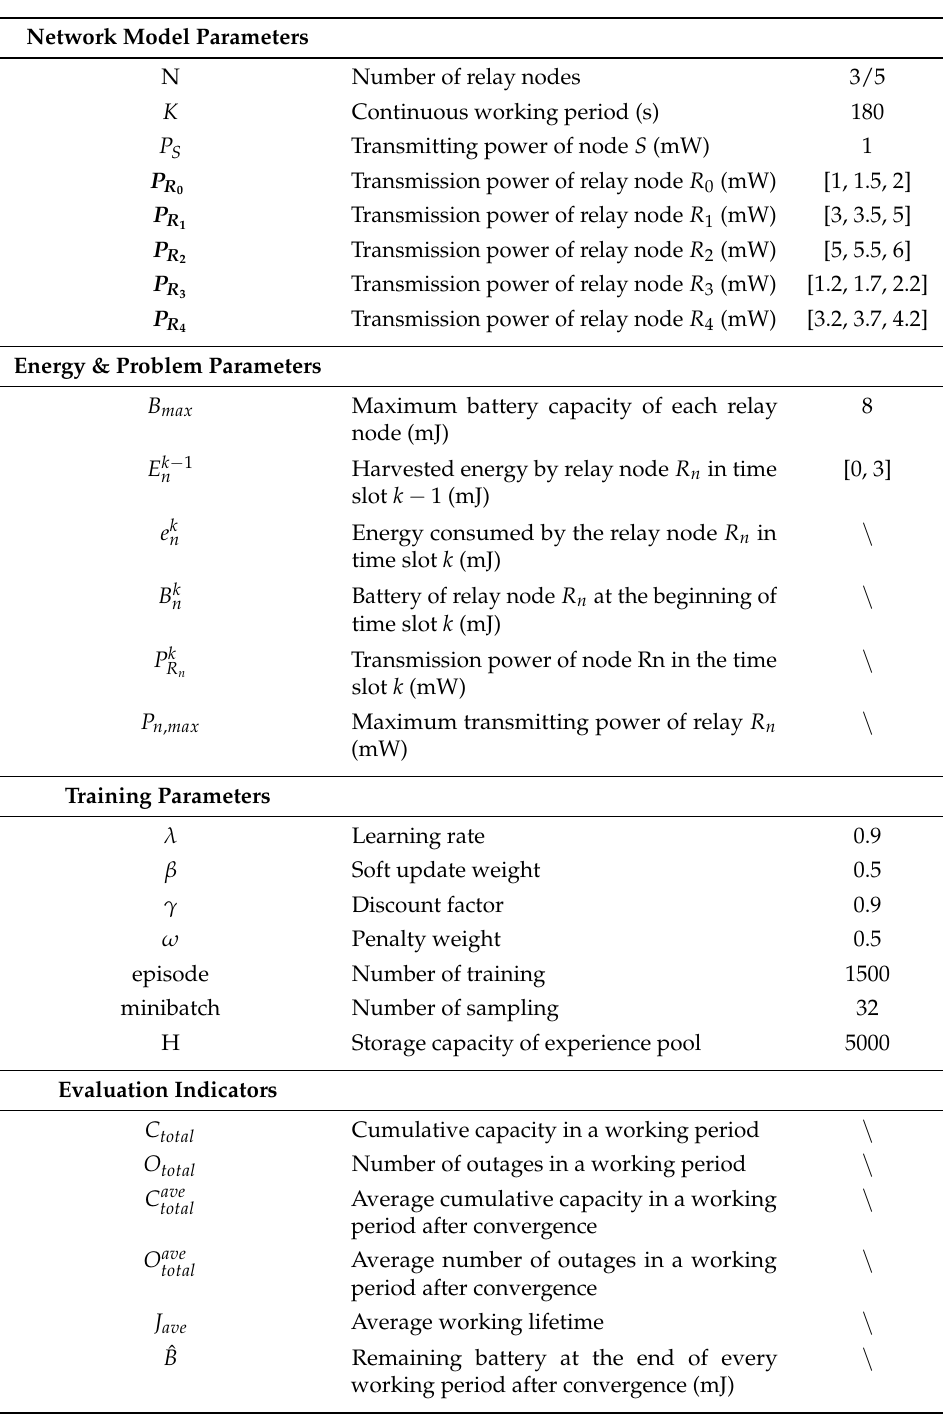
Table 2. Simulation